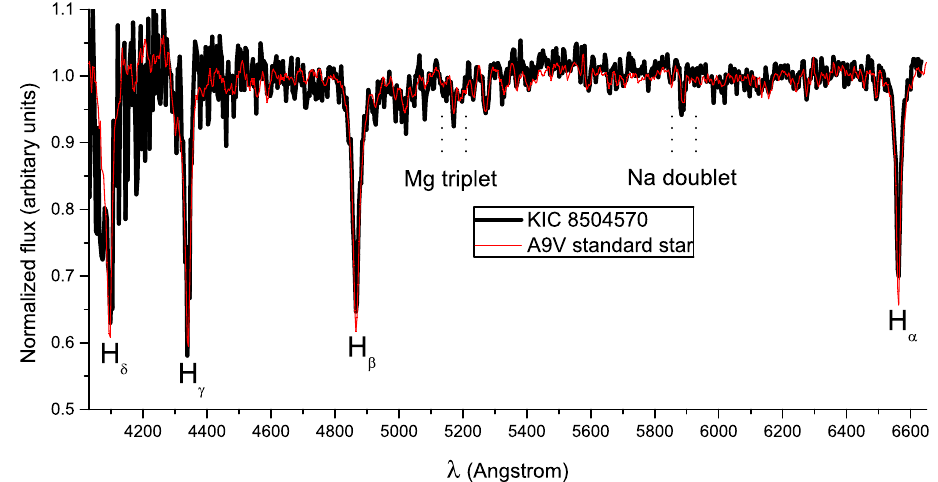
Figure 2. Comparison spectra of KIC 8504570 (black line) and the standard star (red line) with the closest spectral types. The Balmer and some strong metallic lines are also